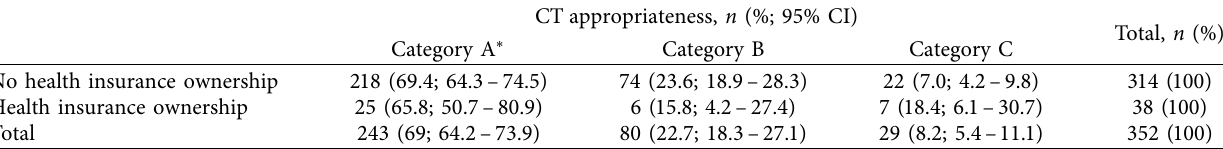
Table 3: Health insurance ownership and CT appropriateness.